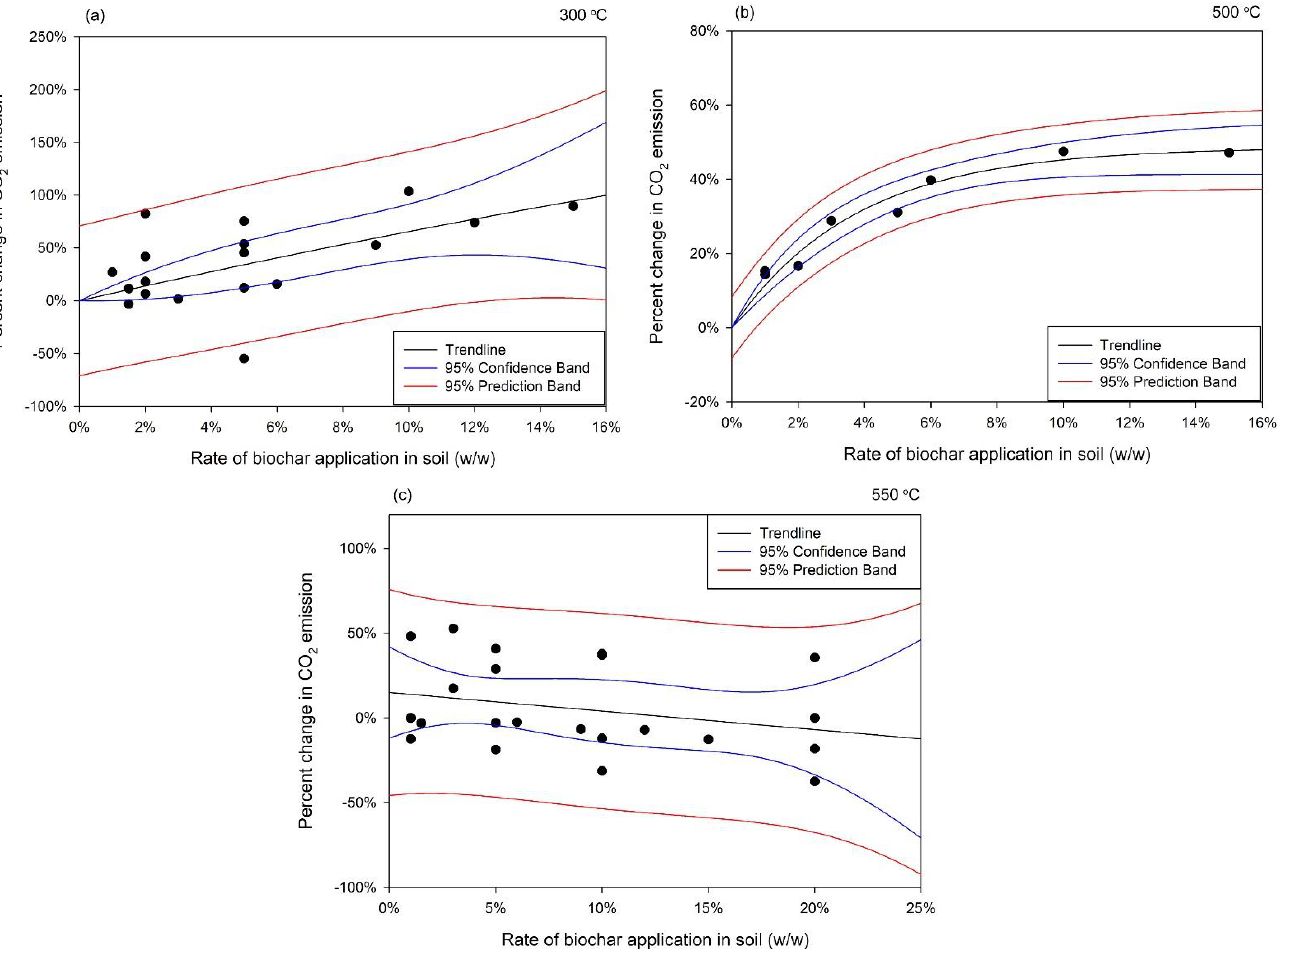
Figure 1. Percentage change in CO 2 emissions as affected by biochar applications at different applica- tion rates ( w / w ): ( a ) applied biochar was produced at approximately 300 ◦ C, ( b ) applied biochar was produced at approximately 500 ◦ C and ( c ) applied biochar was produced at approximately 550 ◦ C. Woody materials were used as feedstock for biochar production via slow pyrolysis. Note: Different units for biochar application rates were all converted into weight percentage, calculated using the mass of applied biochar divided by the mass of impacted soil; the 0% ( x -axis) refers to the control soil with no biochar